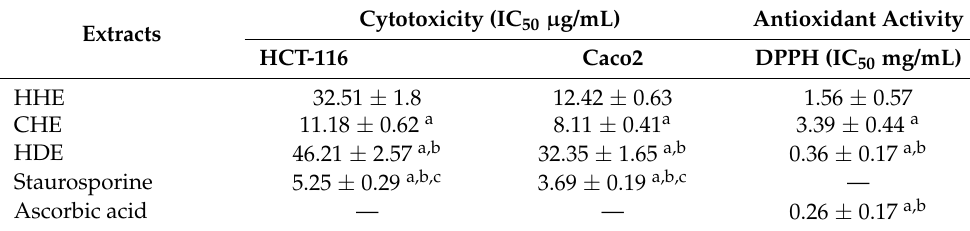
Table 2. Antioxidant and cytotoxic activities of the S. aegyptiaca essential oil extracts.